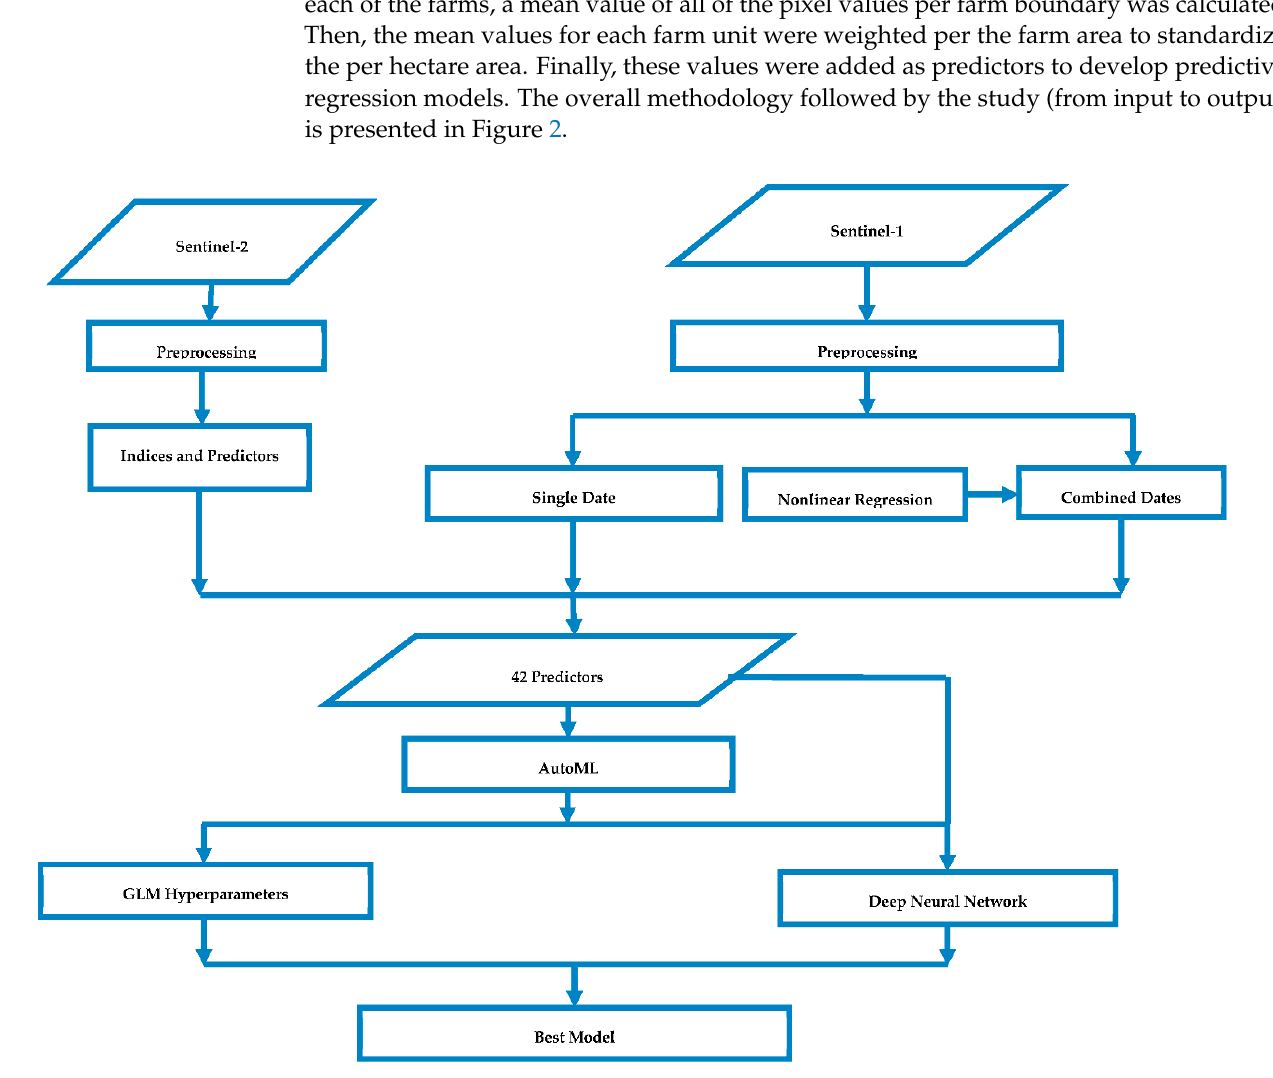
Figure 2. Flow diagram showing the input dataset, derivation of predictors, and the three algo- rithms used.